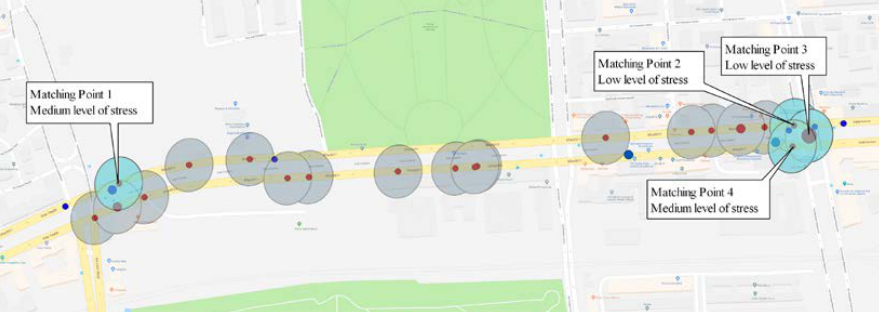
Figure 11. Example of a route—accidents identified in red, and stress points in blue. Circles indicate the buffer around accidental points (QGIS elaboration of Google Maps).